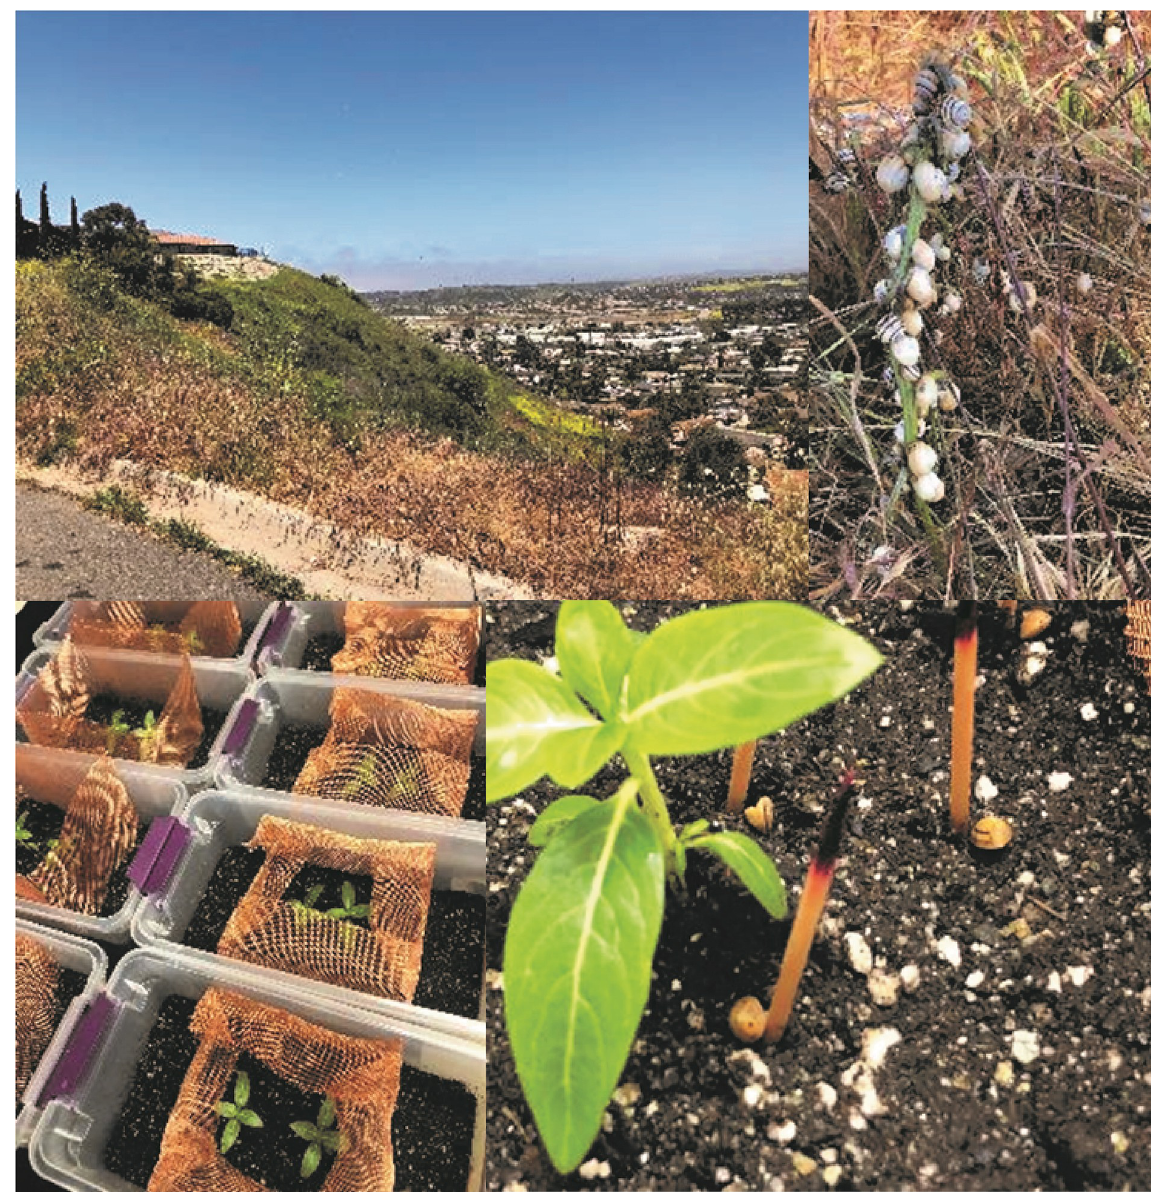
Fig 2. Clockwise from top left: The collection site of Theba pisana in a vacant lot in Oceanside, San Diego (33˚ 12’35” N 117˚ 20’30”W); snails on the vegetation; treatment arenas; and dead snails 7 days after treatment.